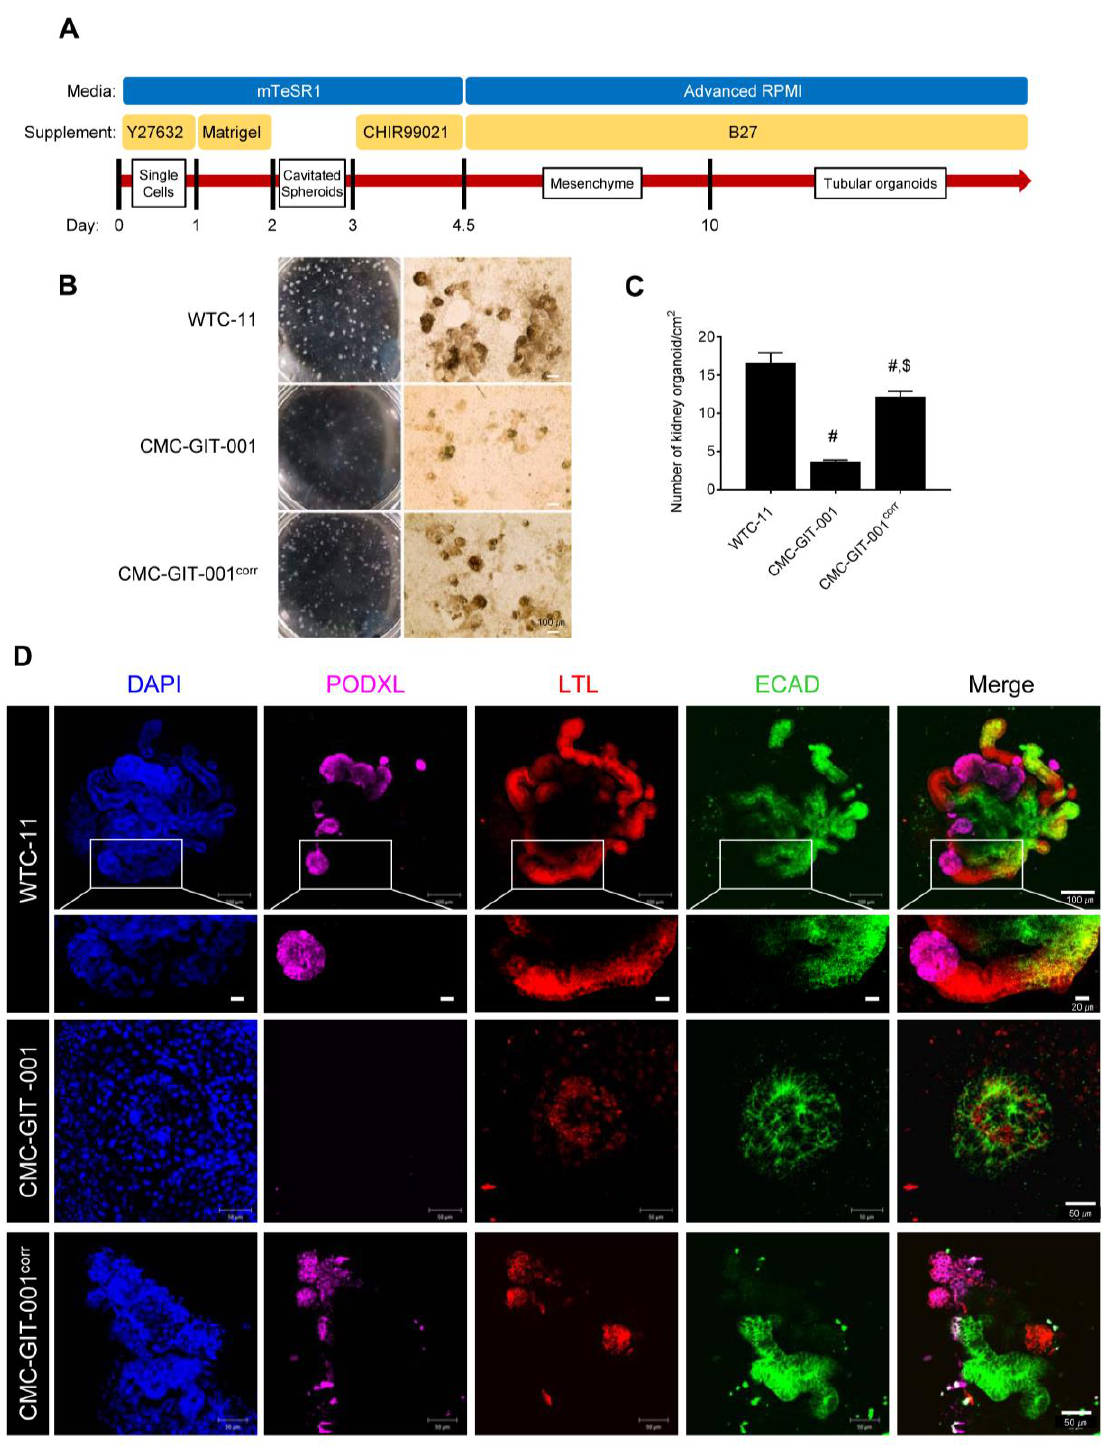
Figure 3. Differentiation of kidney organoids from CMC-GIT-001 and CMC-GIT-001 corr hiPSCs. ( A ) Schematic timeline of the hiPSC differentiation protocol. ( B ) Whole-well bright field observations and light micrograph of the kidney organoids. Scale bar = 100. ( C ) Comparison of the number of matured kidney organoids in CMC-GIT-001 and CMC-GIT-001 corr . Data are presented as mean ± SE. # p < 0.05 vs. WTC-11; $ p < 0.05 vs. CMC-GIT-001. ( D ) Representative immunofluorescence image of PODXL, LTL, and ECAD kidney organoids from WTC-11 as a control, CMC-GIT-001, and CMC-GIT-001 corr . Scale bar = 50 or 100 μm.